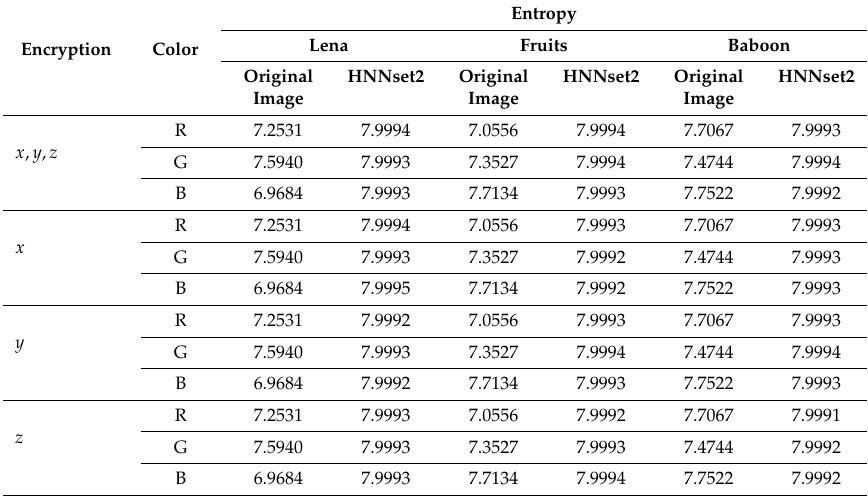
Table 12. Entropies of the original Lena, Fruits and Baboon images and the encrypted ones using the sets of values HNNset2 from Table